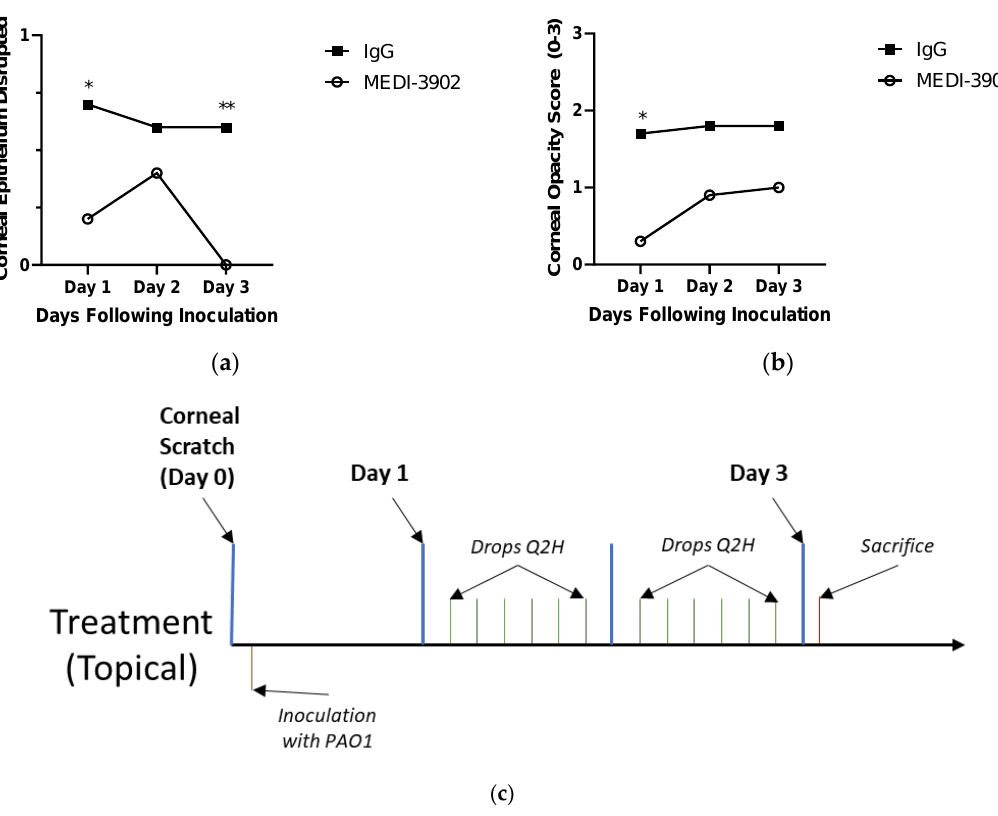
Figure 3. MEDI3902 can treat an established infection of PAO1 when given topically: Mice treated with MEDI3902 ( n = 10) had fully intact epithelia by day three status post treatment as opposed to those treated with IgG ( n = 10) ( a ). Similarly, mice treated with MEDI3902 had an initial decrease in opacity one day status post treatment ( b ); however, this was no longer significant by Day 3. (Mean ± SEM) Opacity scores: MEDI3902 treated Day 1 = 0.3 ± 0.153; IgG treated Day 1 = 1.7 ± 0.473; MEDI3902 treated Day 2 = 0.9 ± 0.407; IgG treated Day 2 = 1.8 ± 0.490; MEDI3902 treated Day 3 1.0 ± 0.422; IgG treated Day 3 1.8 ± 0.490. Epithelial scores: MEDI3902 treated Day 1 = 0.2 ± 0.133; IgG treated Day 1 = 0.7 ± 0.153; MEDI3902 treated Day 2 = 0.4 ± 0.163; IgG treated Day 2 = 0.6 ± 0.163; MEDI3902